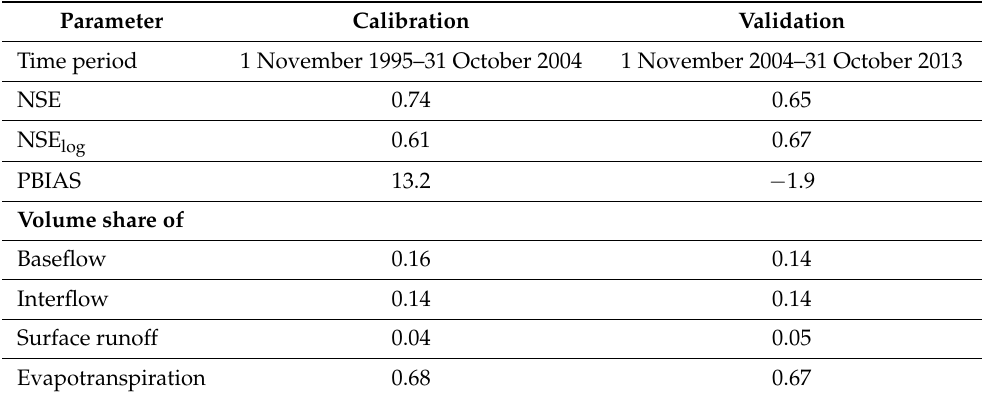
Table 2. Goodness of fit criteria and shares of water balance components for the calibration and validation period.